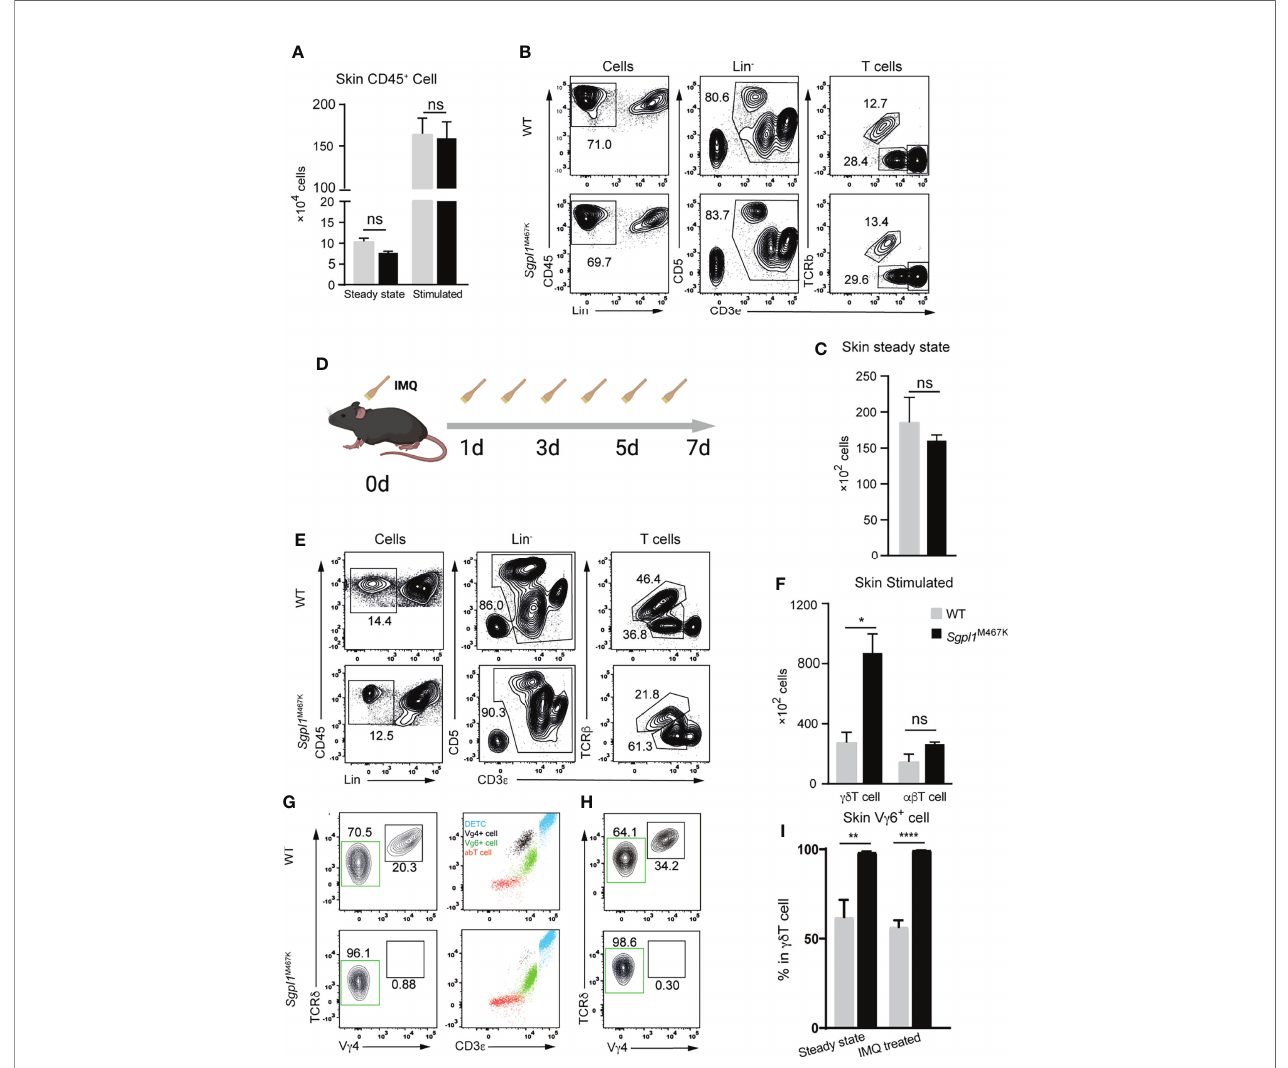
FIGURE 4 | Sgpl1 M467K skin exhibited elevated V gd T cell count after IMQ treatment. (A) Total white blood cell count within steady-state or in fl amed skin (two ears). (B, C) T cell count in steady-state skin determined by fl ow cytometer. (B) Representative fl ow cytometer fi gure, T cells were grouped from the Lin - (not CD11b - or MHCii - ) cells by CD3 + , which was further divided into TCR b + ab T cells and TCR b - CD3 medium gd T cells and CD3 hi dendritic epidermal T cells (DETC). (C) gd T cell count of two ears. (D – F) Skin T cell count after IMQ treatment. (D) Experiment fl ow chart for IMQ application, mouse ears were treated with IMQ from day 0 to day 6. (E) Representative fl ow cytometer fi gure, the same as (B) ; (F) absolute T cell count after IMQ stimulation. (G – I) V g 4 V g 6 gd T cell subsets within the steady- state or in fl amed ear. (G) Representative fl ow cytometer fi gure of steady-state skin; left, V g 4 or V g 6 subpopulation composition of skin gd T cells; right, blue dots are CD3 hi gd T hi DETC, red dots are gd T - CD3 low ab T, black dots are CD3 medium gd T medium V g 4 + T cells, green dots are V g 4 - CD3 bright gd T low V g 6 T cells. (H) Representative fl ow cytometer fi gure of V g 4, V g 6 cells within in fl amed skin. Representative fi gure of steady-state skin data were displayed from one of three independent experiments, which analyzed thirteen wild-type mice and eleven mutant mice; in fl amed skin data is from two independent experiments, which analyzed six wild-type mice and six mutants; steady-state ear V g 4 V g 6 distribution data were pooled from two experiments, which analyzed eight wild-type and six mutant mice; in fl amed ear V g 4, V g 6 distribution data displayed are from one experiment, which analyzed four wild-type and four mutant mice; ****, p<0.0001; **, p<0.01; *, p<0,05; ns, not signi fi cant; unpaired